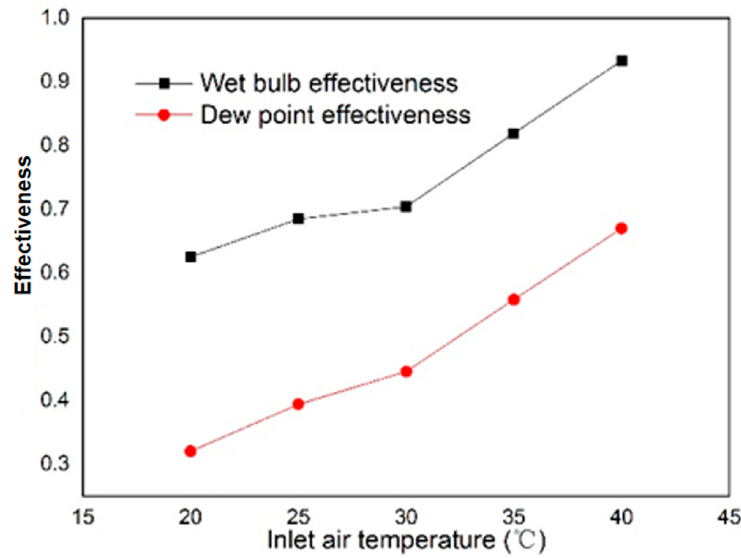
Figure 11. Wet-bulb and dew-point efficiency under different inlet air temperature conditions.